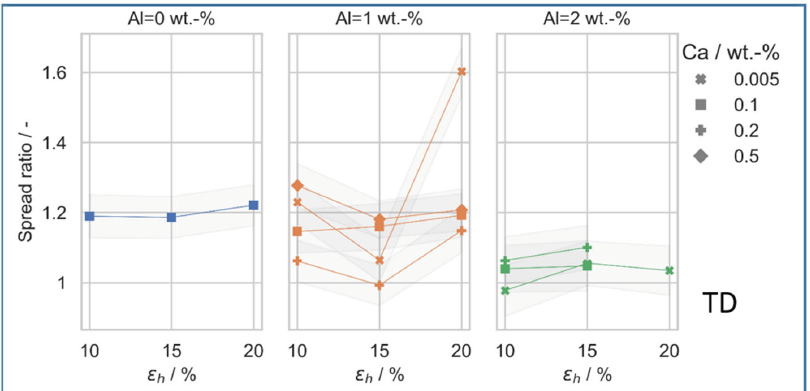
Figure 8. Spread ratio of the peak shape related to the relative height reduction ( ε h ) towards RD/TD of the pole figures for S_TD samples, including the error in the spread towards RD and TD estimated at 1.75° (half of the resolution).